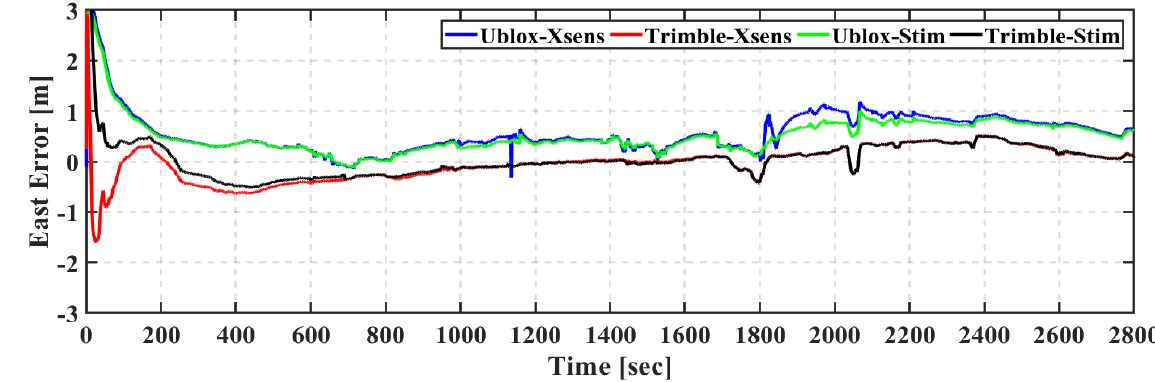
Figure 12. Second field trial: East positioning error of real-time TC GNSS PPP/INS for Ublox–Xsens, Trimble–Xsens, Ublox–Stim, and Trimble–Stim solutions.